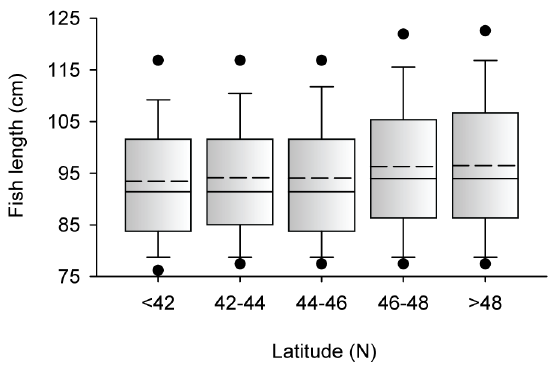
Figure 7. Length of fish by latitude for July to September. Dashed line is the mean; symbols are the 5 th and 95 th percentiles.